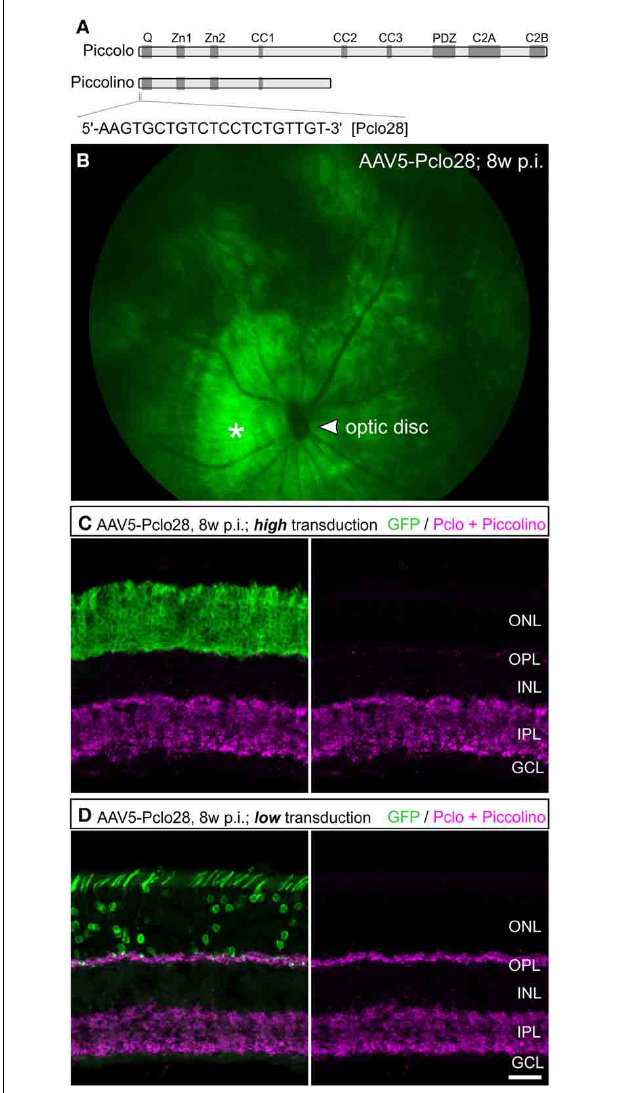
FIGURE 1 | Targeted delivery of Piccolo shRNA to rod photoreceptors of the mouse retina via subretinal injection of AAV5. (A) Schematic multidomain structure of the conventional and ribbon synaptic Piccolo variants (Piccolo and Piccolino, respectively), and location and sequence of the shRNA (Pclo28) used to down regulate Piccolino. (B) In vivo fluorescence fundus photography showing mouse opsin promoter driven GFP expression in transduced rod photoreceptors 8 weeks post injection (8w p.i.). The asterisk demarcates the approximate site of injection where the transduction rate is highest. (C,D) Images of vertical sections through an AAV5-Pclo28-transduced retina displaying high (C) and low (D) transduction rate, stained with an antibody against GFP (green) and the antibody Pclo44a, labeling both Piccolo and Piccolino (magenta). ONL: outer nuclear layer; OPL: outer plexiform layer; INL: inner nuclear layer; IPL: inner plexiform layer; GCL: ganglion cell layer. Scale bar in (D) for (C,D) : 20 μ